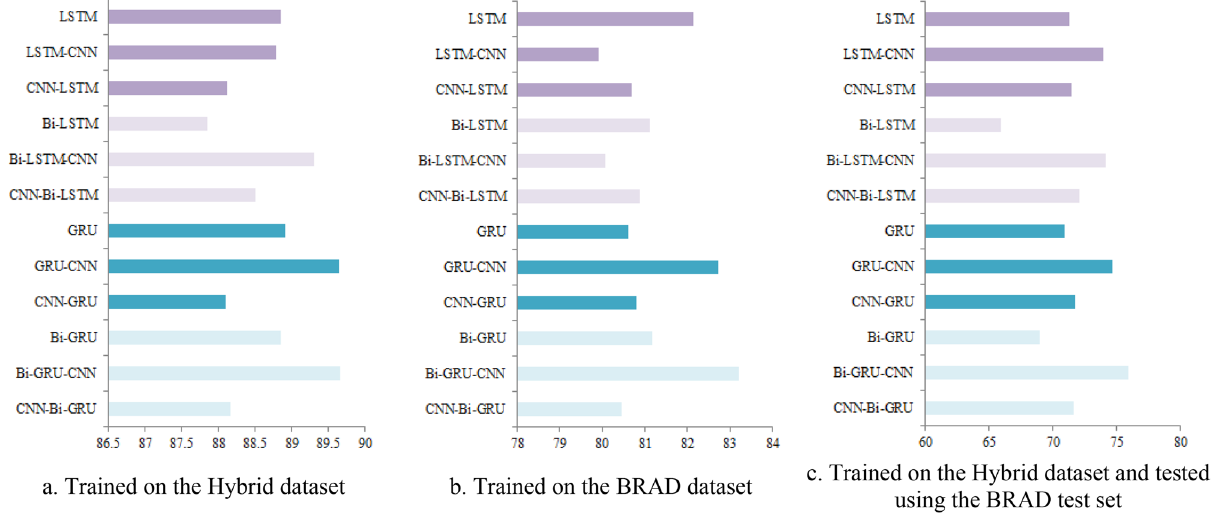
Figure 5. Accuracy of LSTM/GRU based architectures (created by Microsoft PowerPoint 2010).